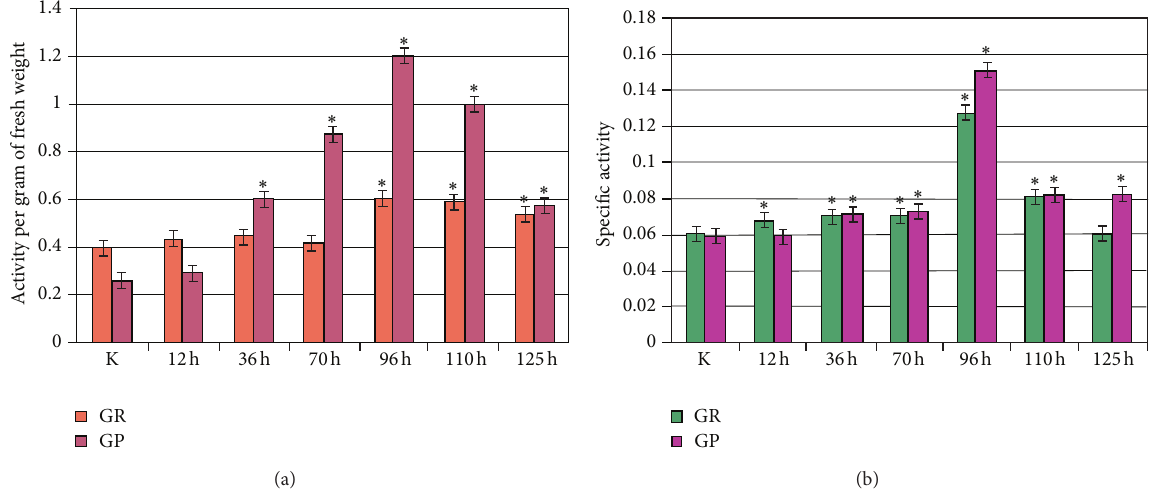
Figure 3: Activity of glutathione reductase and glutathione peroxidase, presented in the form of E per gram of fresh weight (a) and specific activity (b) in the liver of rats in normal conditions (K) and the dynamics of experimental toxic hepatitis. Compared with control: ∗ 𝑃 < 0.05 .